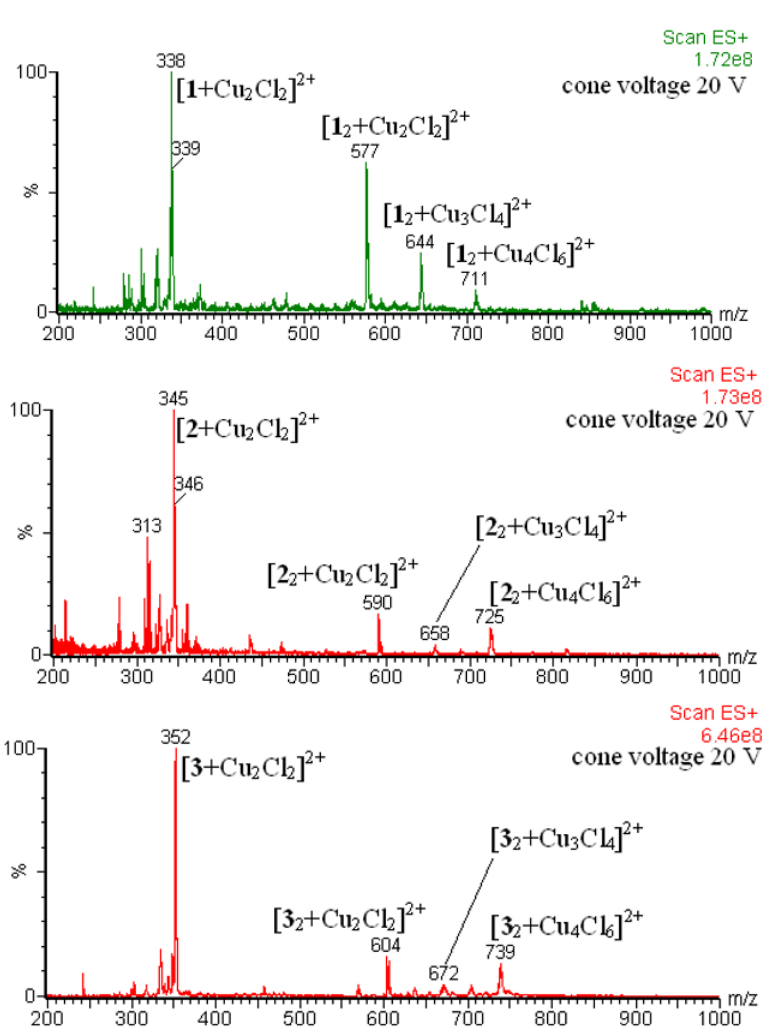
Figure 4. ESI mass spectra of solution containing one of the ligand and excess of